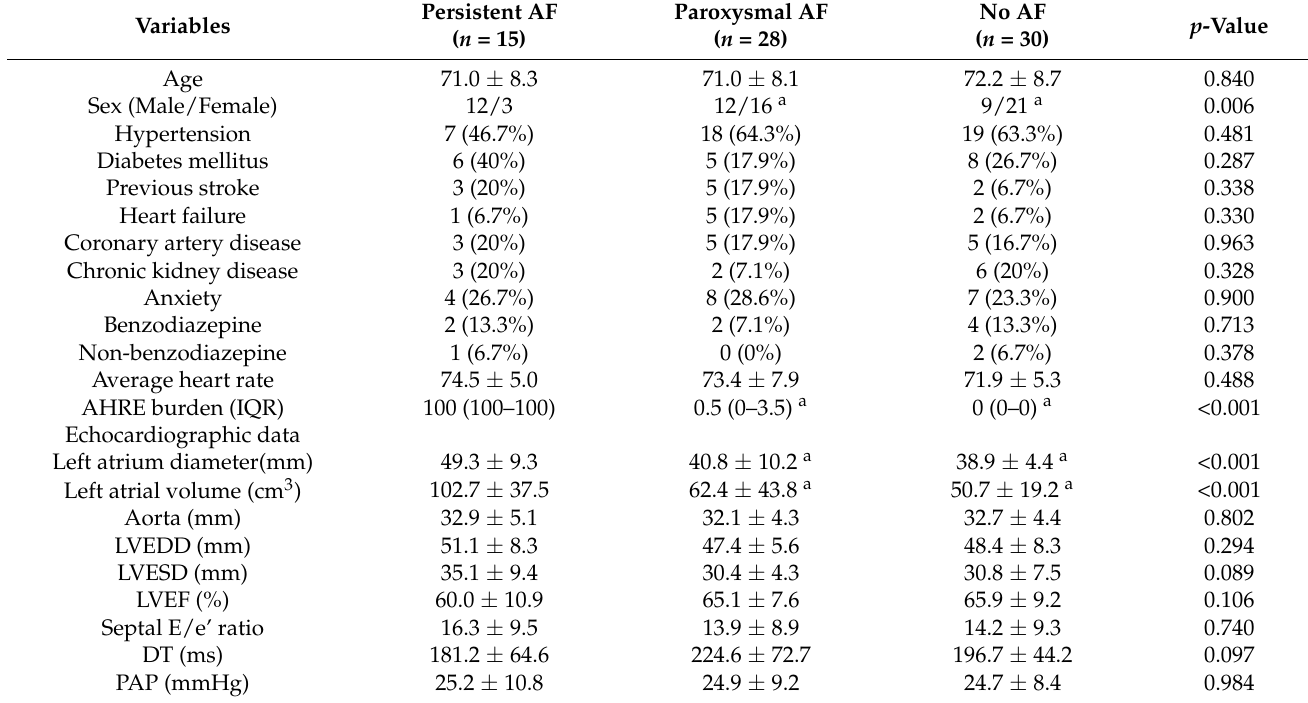
Table 1. Baseline characteristics of the 73-subject study